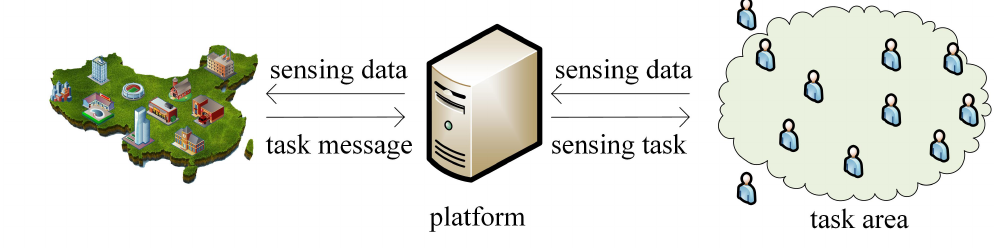
Figure 1. Data collection